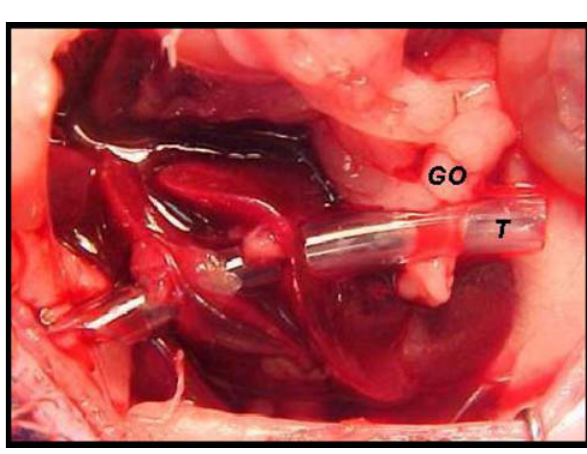
FIGURE 1 - Transfixation of the right hepatic lobe with the aid of a transfixer ( T ) guiding the greater omentum ( GO ),